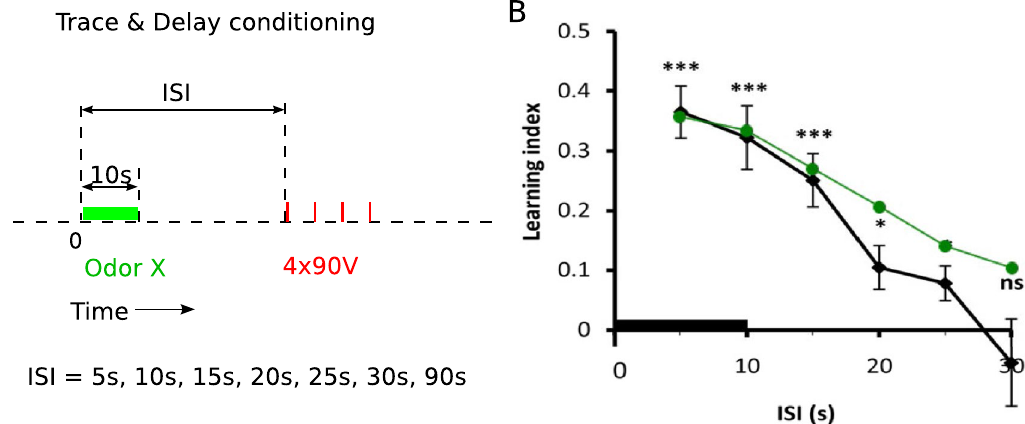
Figure 5. Trace conditioning is faithfully reproduced. (A) Experimental protocol of trace conditioning, with variable Inter-Stimulus Intervals (ISIs) from the onset of the odor (green) to the onset of the electroshock train ( 4 ∗ 90 V, 0.2Hz, each 1.25s, red bars). (B) The LI tested immediately after the conditioning with the different ISIs (reproduced from 28 ). The model roughly captures this data (green line) without additional fitting of the